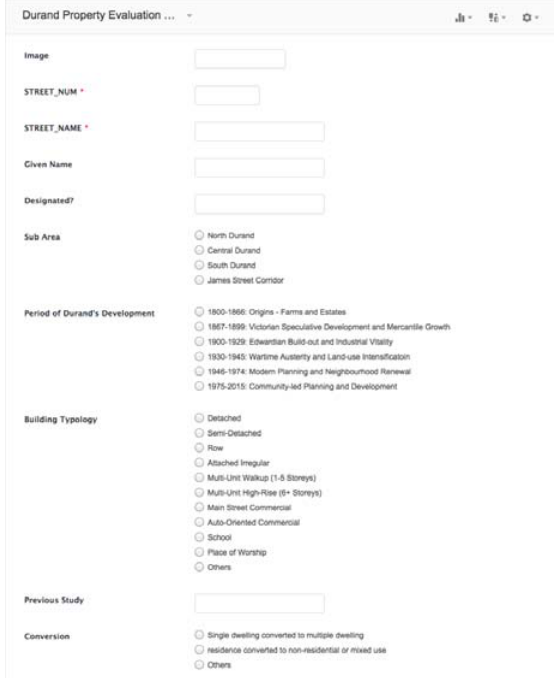
Figure 2. Tablet screen capture of Survey Form